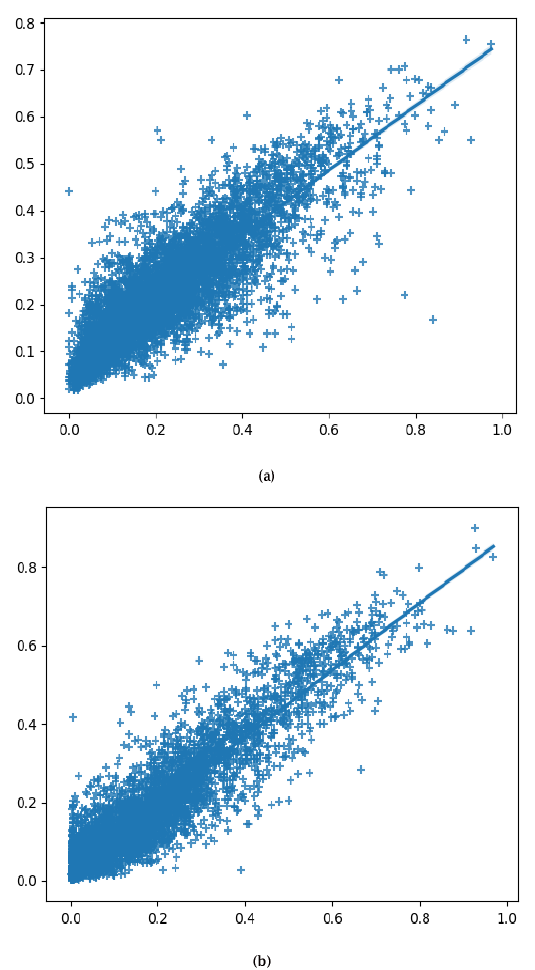
Figure 2. Regression lines of RF for Wanshouxigong Weather Station Data (a) for NO 2 and (b) for O 3